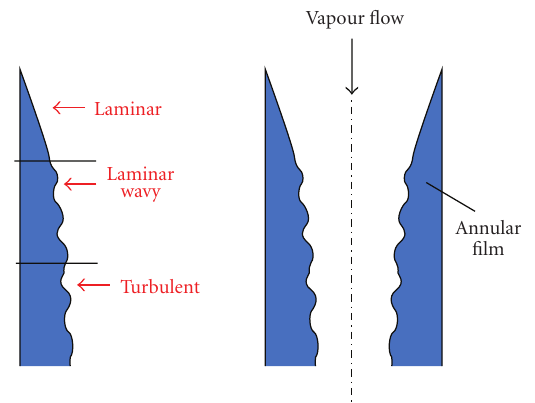
Figure 11: Sketch of film condensation inside a vertical tube.